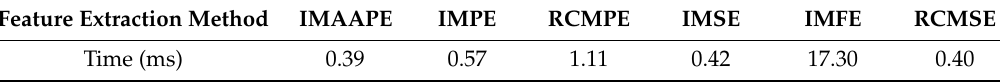
Table 6. Time required by di ff erent feature extraction methods.